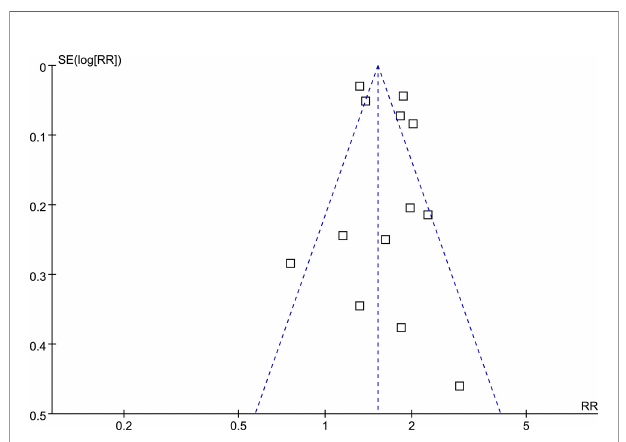
FIGURE 5 | Funnel plots for the meta-analysis of the association between MetS